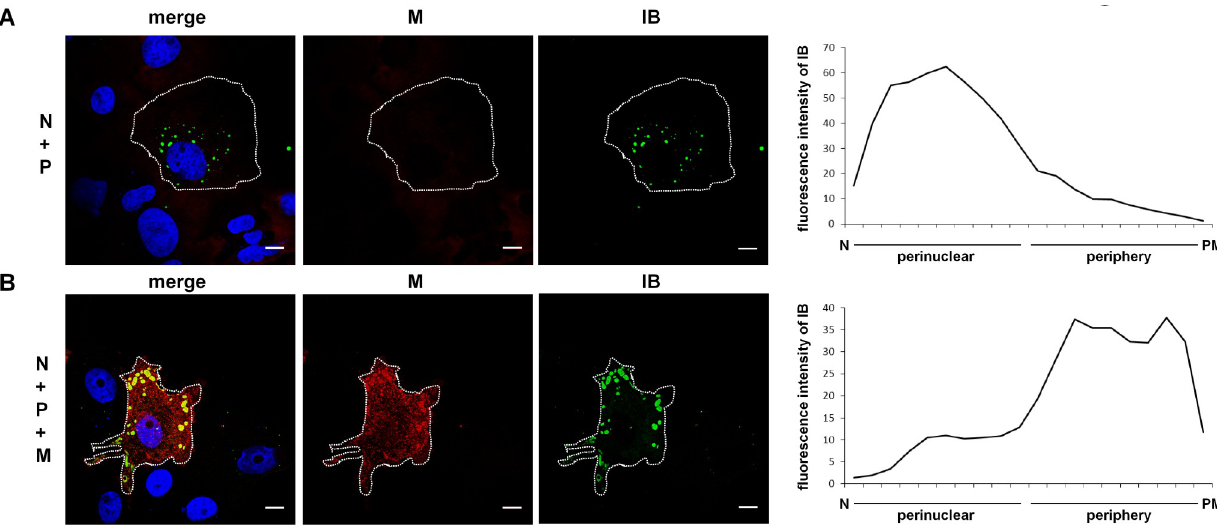
Fig 3. Formation and localization of IBs in the absence and presence of NiV M. (A) To induce IB formation plasmid-encoded NiV N and NiV P proteins were coexpressed (N+P). (B) N and P proteins were expressed together with the NiV M protein. 24 h after transfection, cells were fixed, permeabilized with Triton X-100 and incubated with an M-specific peptide serum (red, M) and NiV N-specific antibodies (green, IB). Nuclei were counterstained with DAPI (blue). Scale bars, 10 μ m. Right panels: To quantify the intracellular localization of IBs (green) in the perinuclear region and the periphery, an ImageJ based quantification tool (IB-LoM) was used. The average IB distribution (quantified in confocal sections of 5–6 cells from three independent experiments) is shown. N, nucleus; PM, plasma membrane.